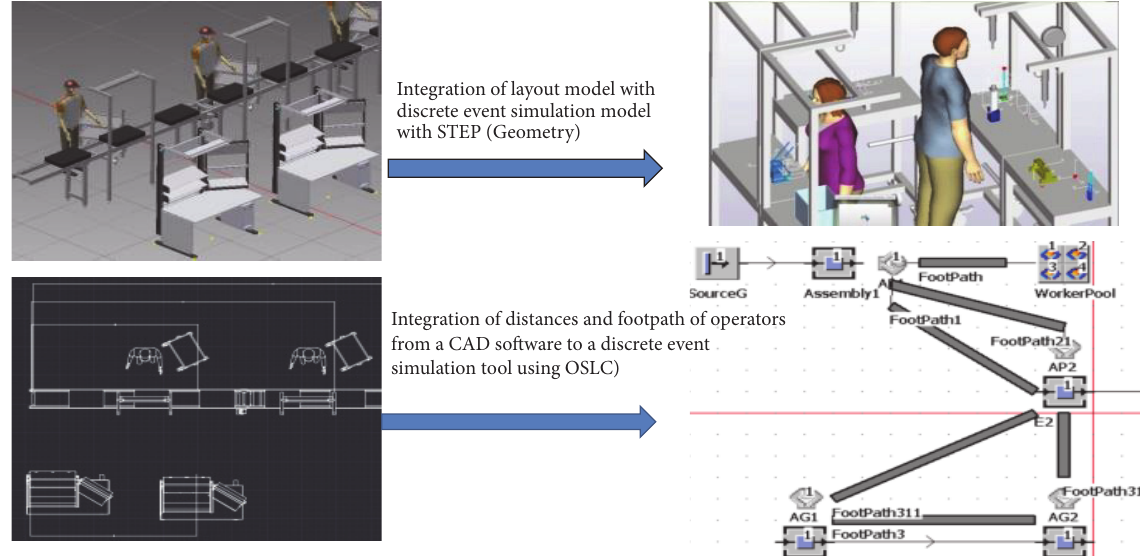
Figure 5: OSLC integration versus STEP integration.